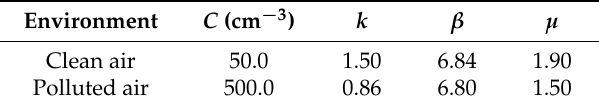
Table 2. Activation spectrum coefficients used for clean and polluted